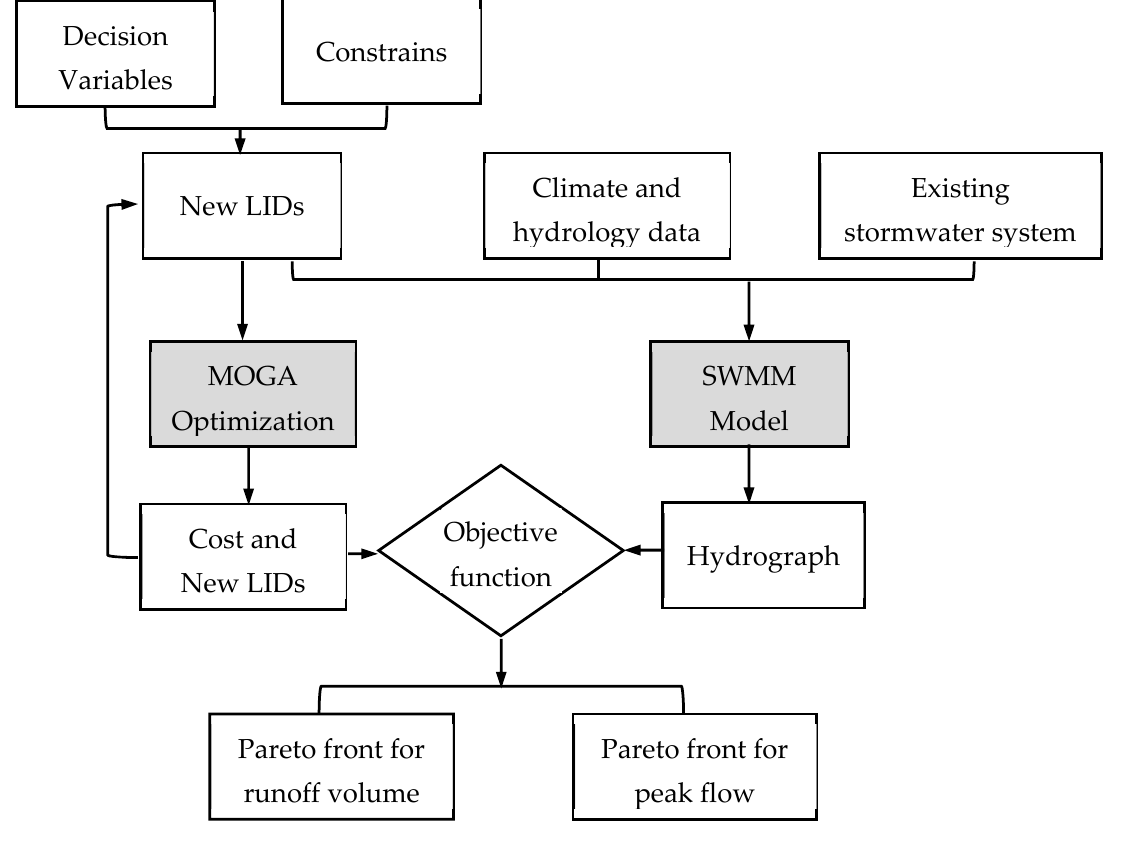
Figure 2. The modeling framework, integrating SWMM and MOGA.